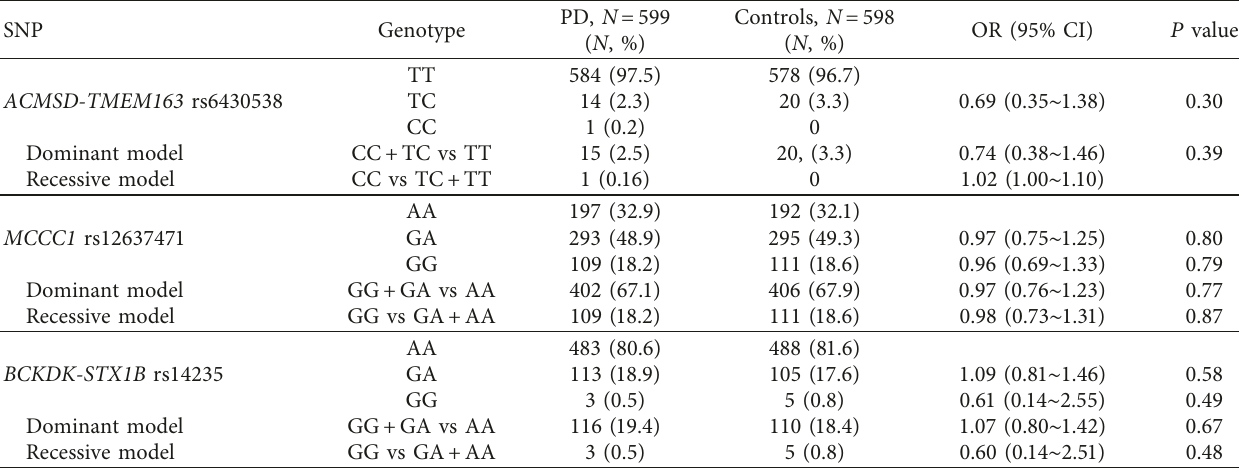
Table 3: Genetic models of single nucleotide polymorphisms (SNPs) in Parkinson’s disease (PD) patients and controls. SNP